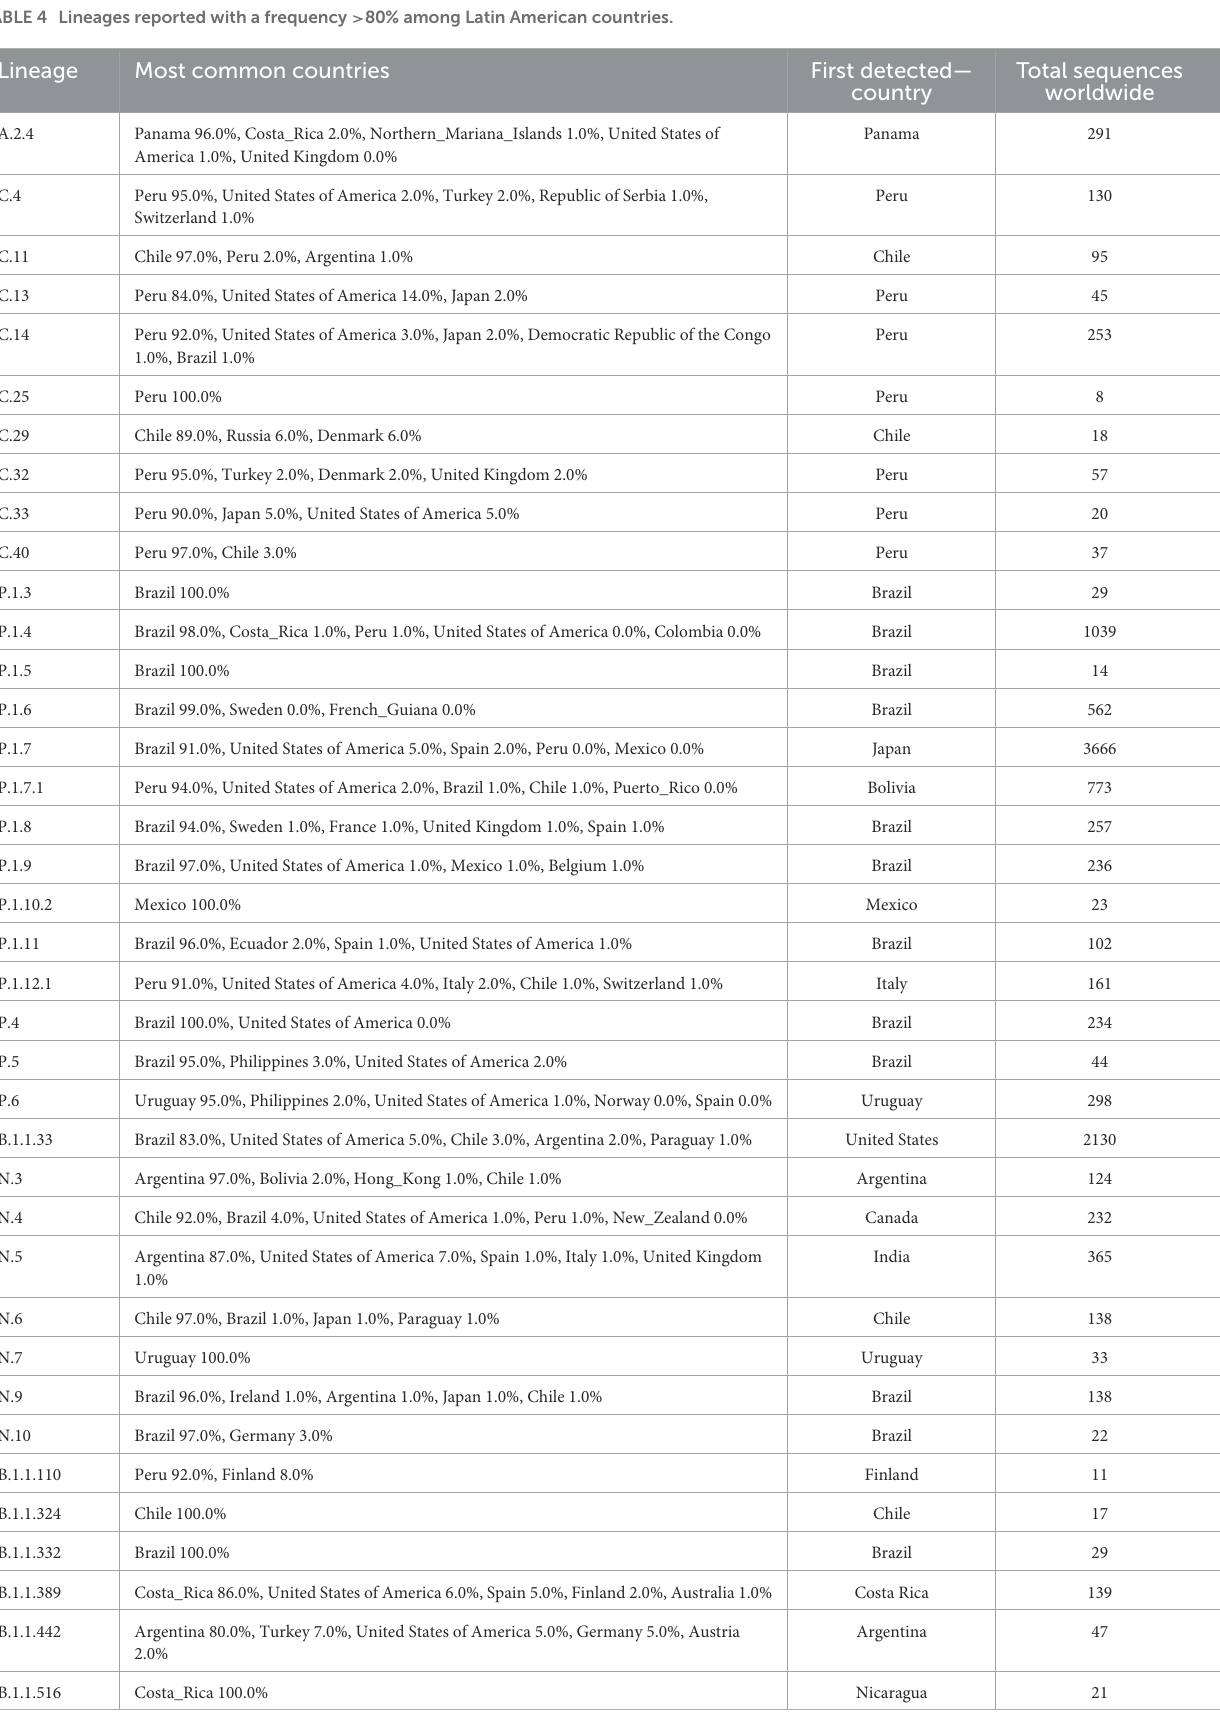
TABLE 4 Lineages reported with a frequency > 80% among Latin American